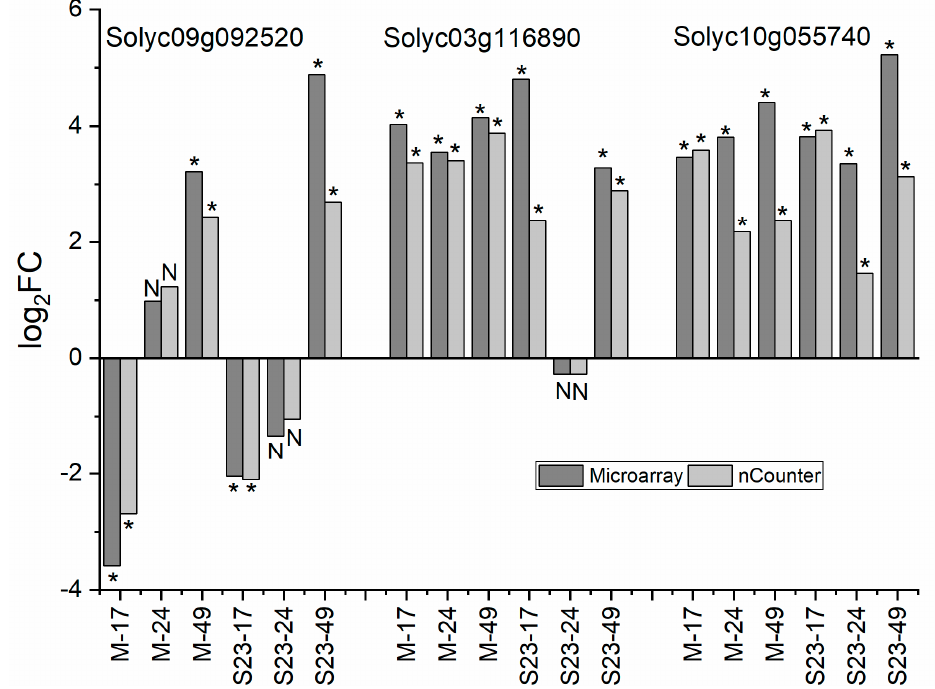
Figure 9. Validation of microarray results by Nanostring nCounter analysis. * p < 0.05; N, not statistically significant.